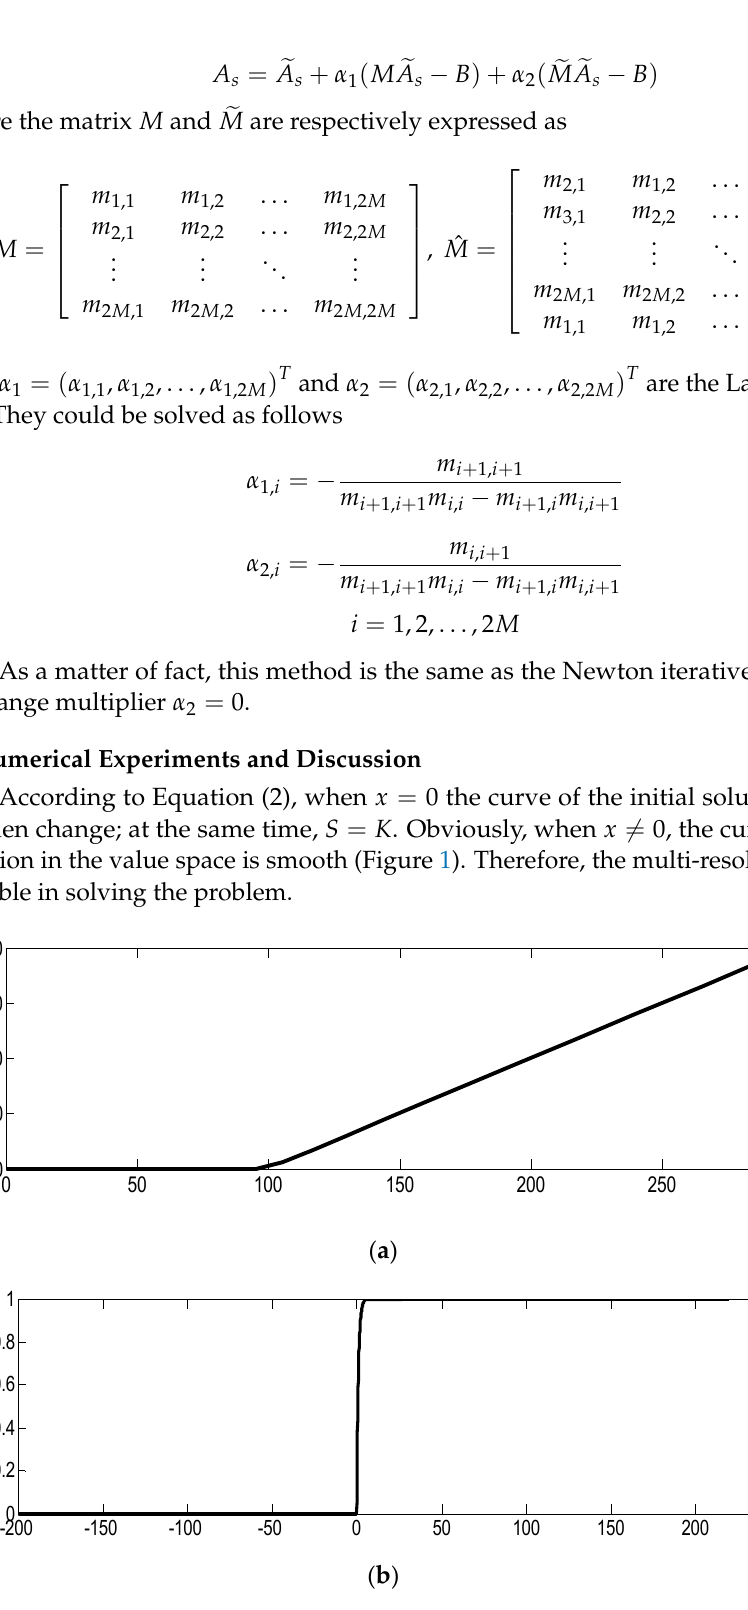
Figure 1. Initial condition of Black–Scholes model ( a ) option price, ( b ) option price transformation.